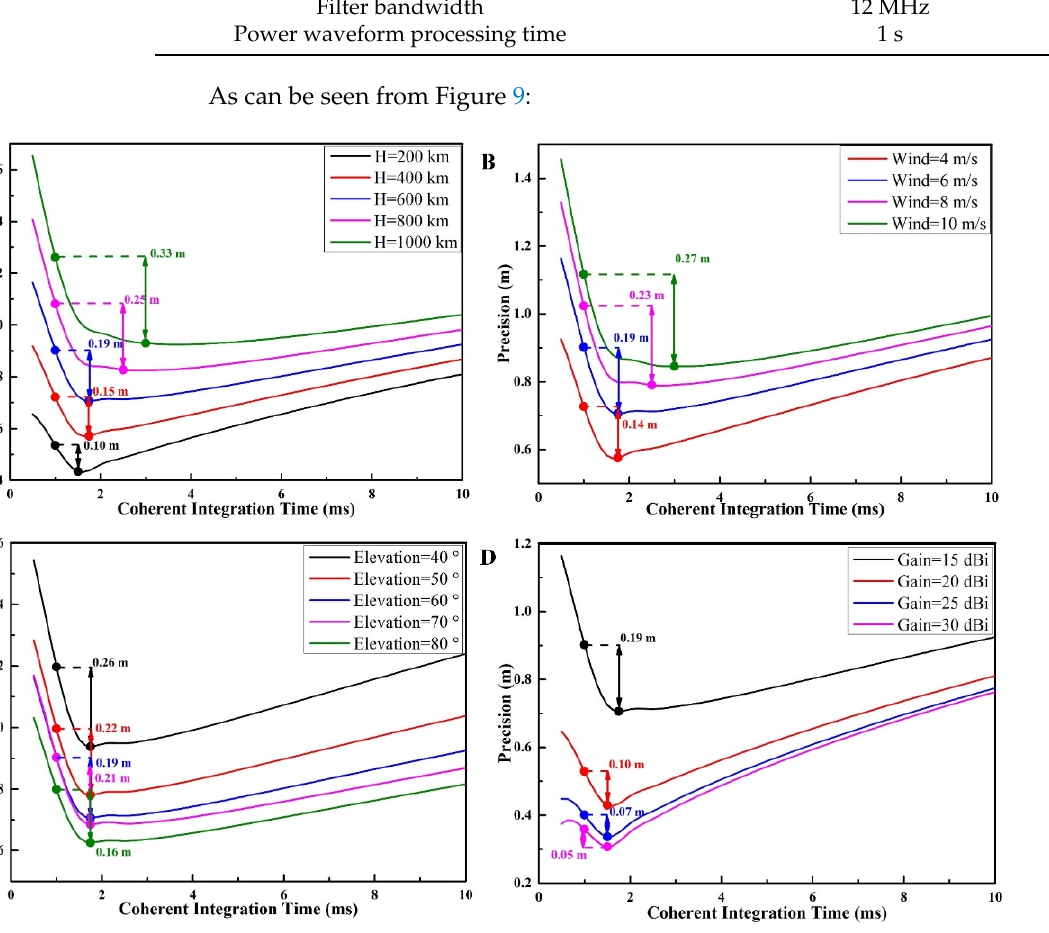
Figure 9. The simulation variation curves of the estimated altimetric precision with the coherent integration time under different conditions. ( A ) When the wind speed is 6 m/s, the elevation is 60 ◦ , the antenna gain is 15 dBi, and the orbit altitude varies. ( B ) When the orbit altitude is 600 km, the elevation is 60 ◦ , the antenna gain is 15 dBi, and the wind speed varies. ( C ) When the orbit altitude is 600 km, the wind speed is 6 m/s, the antenna gain is 15 dBi, and the elevation